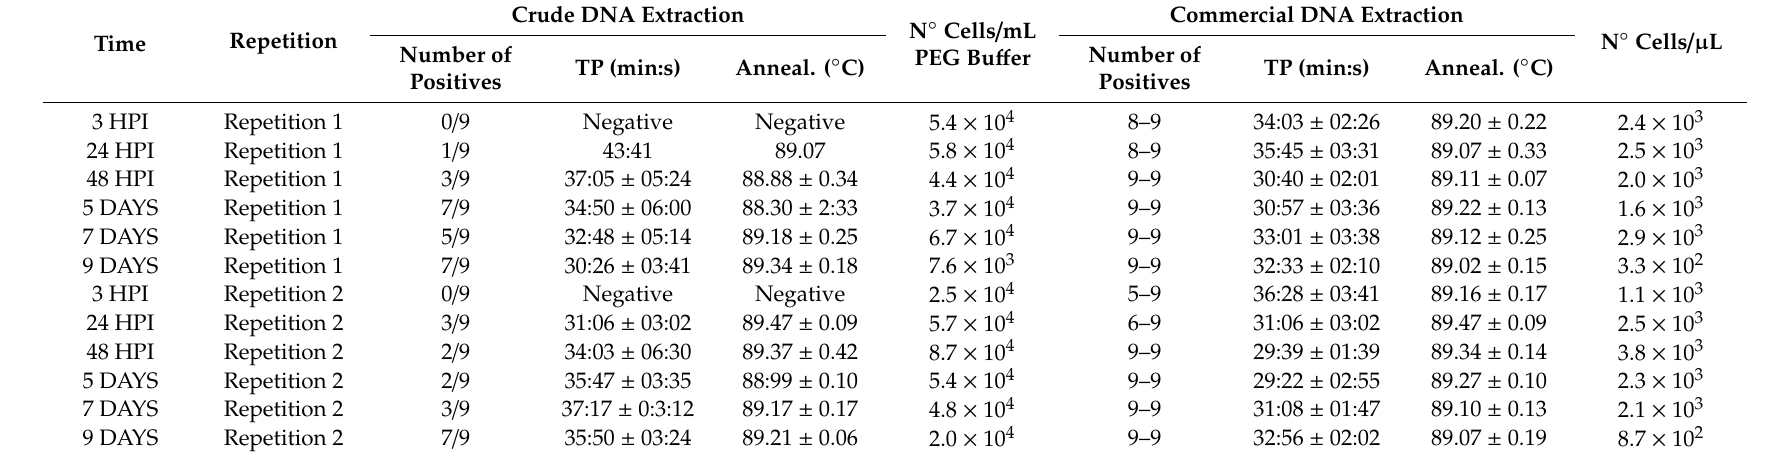
Table 4. Sensitivity testing over time of Venturia -free apple leaves, inoculated artificially with 20 µ L of V. inaequalis suspension at di ff erent time points. The LAMP assay was carried out with both types of DNA extraction (crude extraction and commercial extraction). Approximate number of cells in the crude DNA extraction and in the final elution of the commercial DNA extraction was calculated with the qPCR assay. Average of three replicates is reported. Tp = time to positive, Anneal. = annealing temperature. HPI: hours post